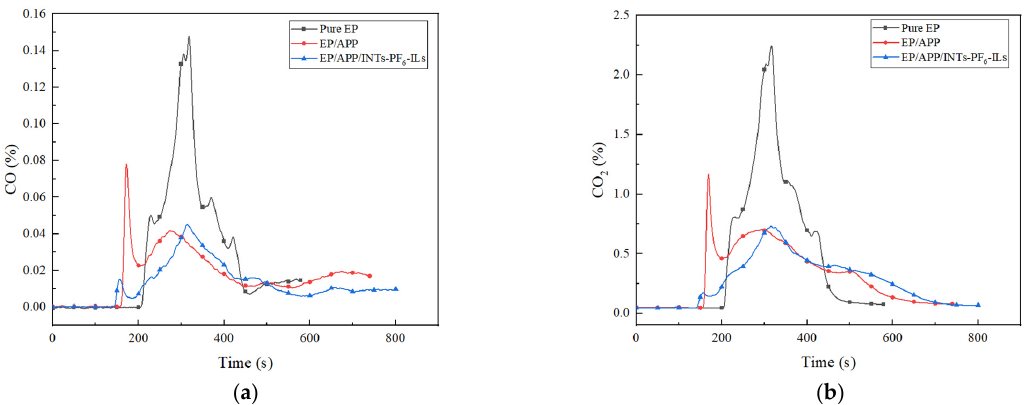
Figure 5. ( a ) Y CO curves of EP composites; ( b ) Y CO2 curves of EP composites.